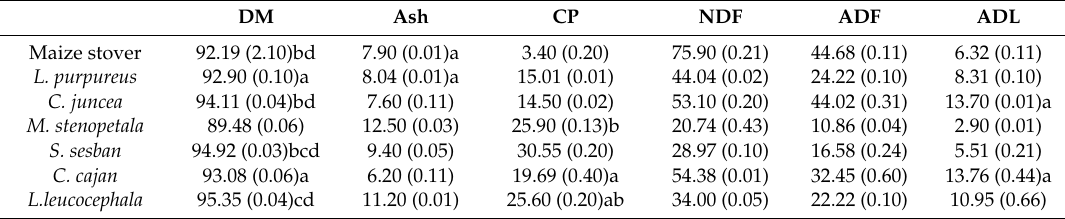
Table 2. Mean (%) chemical composition of the studied